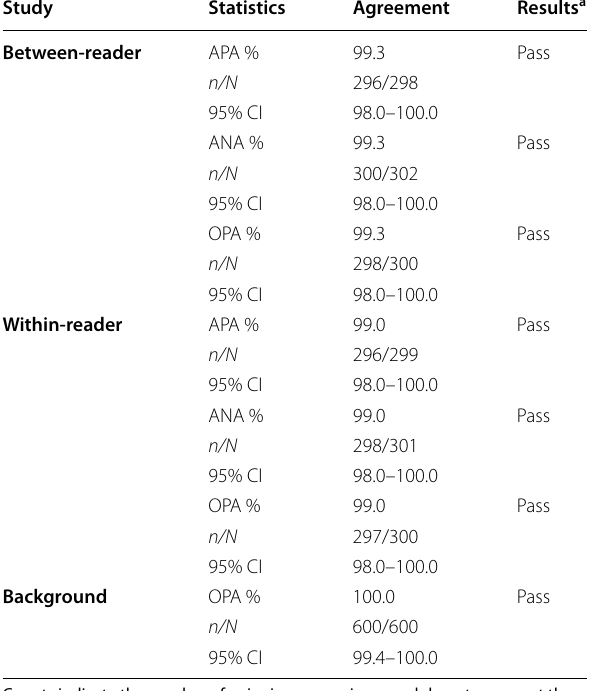
Table 2 TAP scoring precision for determining PD-L1 expression level in the internal study (including borderline cases)